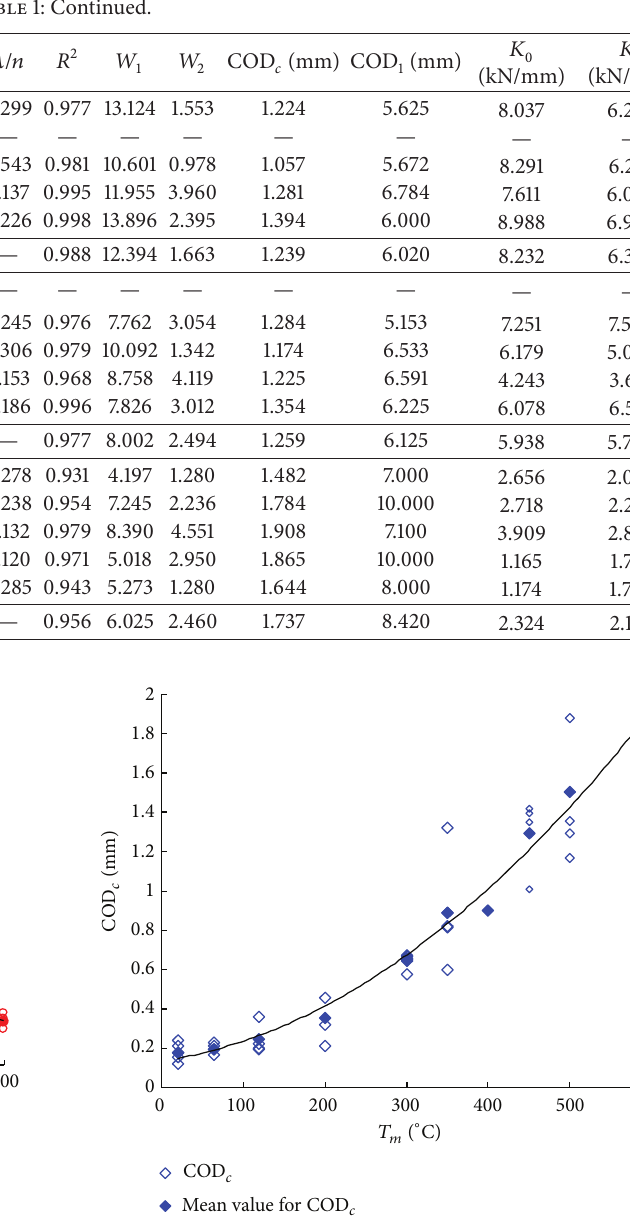
Figure 7: Variation tendency of 𝑃 ℎ max with 𝑇 𝑚 .